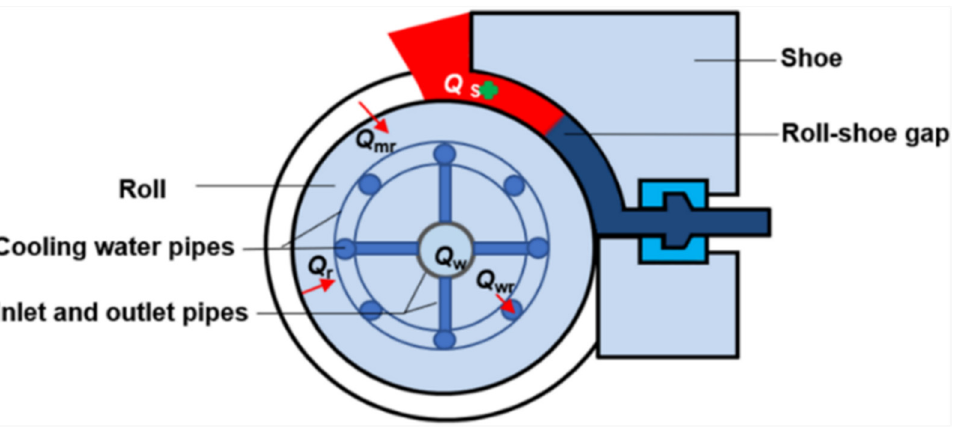
Figure 1. Schematic physical model of the continuous rheo-extrusion process. During the solidification process of melt in the roll-shoe gap, there are two parts